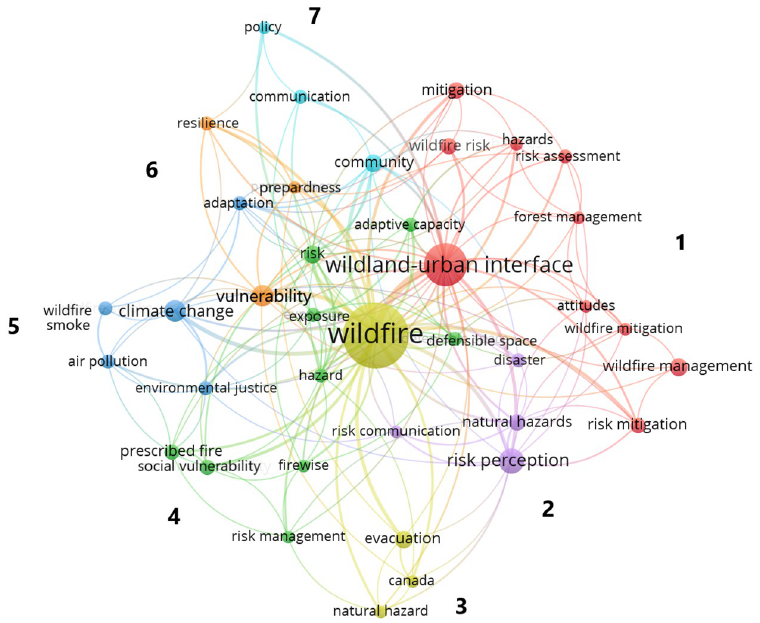
Fig 3. Network of author-identified keywords in the socio-demographic dimensions of wildfire literature with a minimum occurrence of five. Total link strength = 394. Numbers refer to the different clusters.